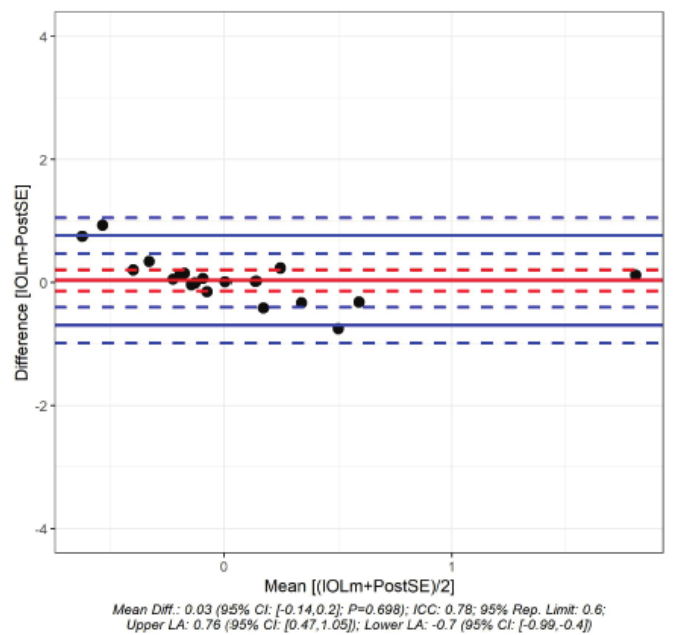
Figure 1. Bland–Altman Plot to visualize the difference of the IOLM to post OP SE.